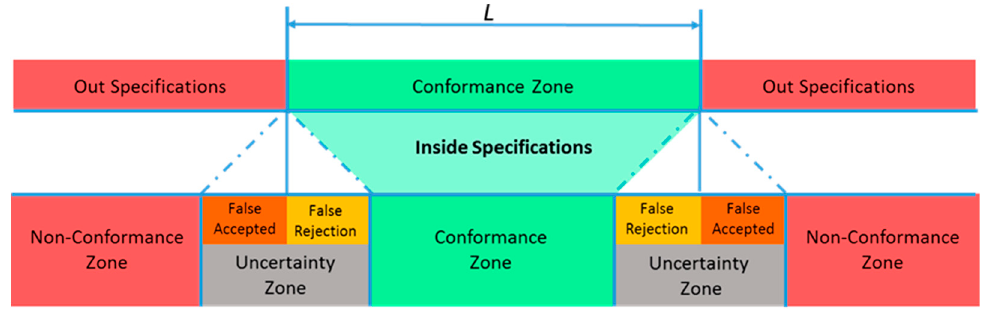
Figure 1. Influence of uncertainty on the conformance zone.